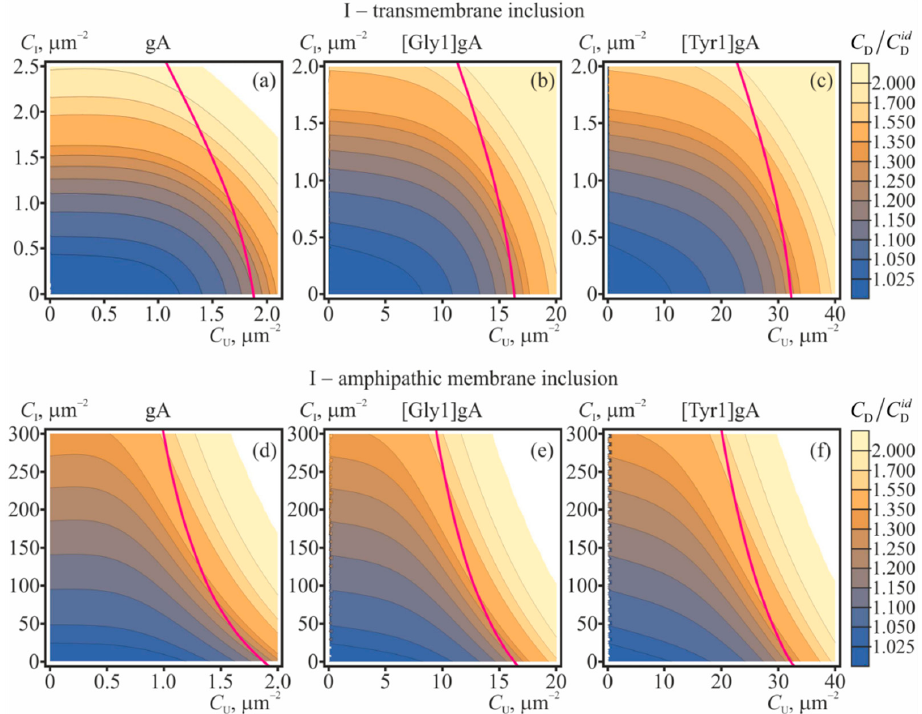
Figure 4. The dependence of the equilibrium concentration of conducting dimers on concentrations of gramicidin monomers and membrane inclusions: ( a – c )—transmembrane inclusions; ( d – f )—amphipathic membrane inclusions, incorporated into the top monolayer. The value C D / C id = 1 + ∆ C D / C id is plotted for: ( a , d )—gA, ( b , e )—[Gly1]gA, ( c , f )—[Tyr1]gA. The magenta curves bound the range of concentrations where the correction to the main approximation calculated within the perturbation theory reaches 20%; for larger C U , C I concentrations the application of the perturbation theory is not strictly valid. The illustrated dependences of C D / C id were obtained based on Equation (24).